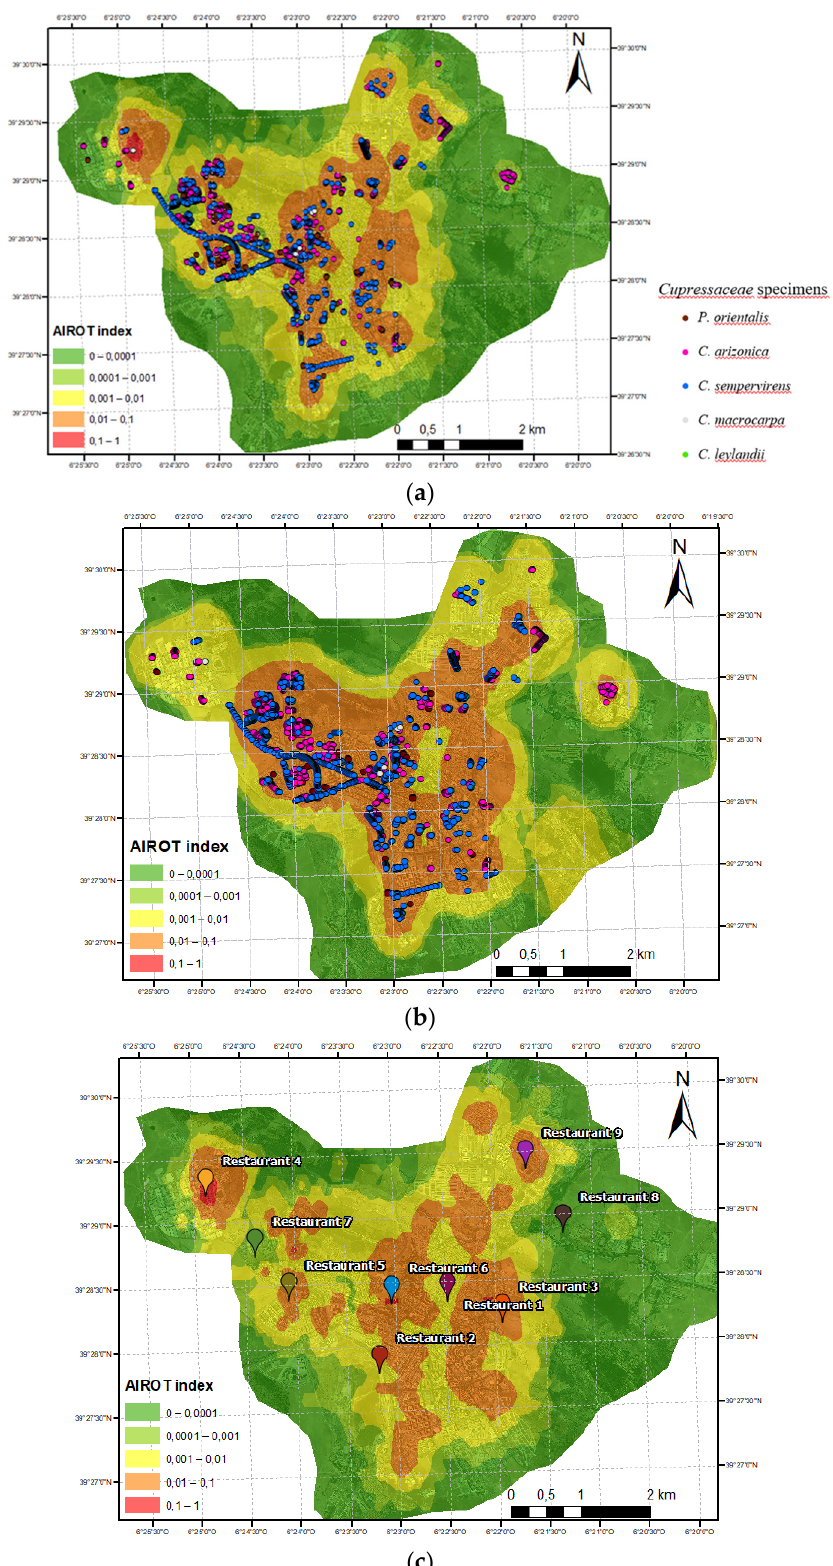
Figure 2. Risk maps of Cáceres for the month of February according to the AIROT index in which are indicated: ( a ) risk map taking into account the parameter α , ( b ) risk map without including the parameter α , and ( c ) restaurants risk map.